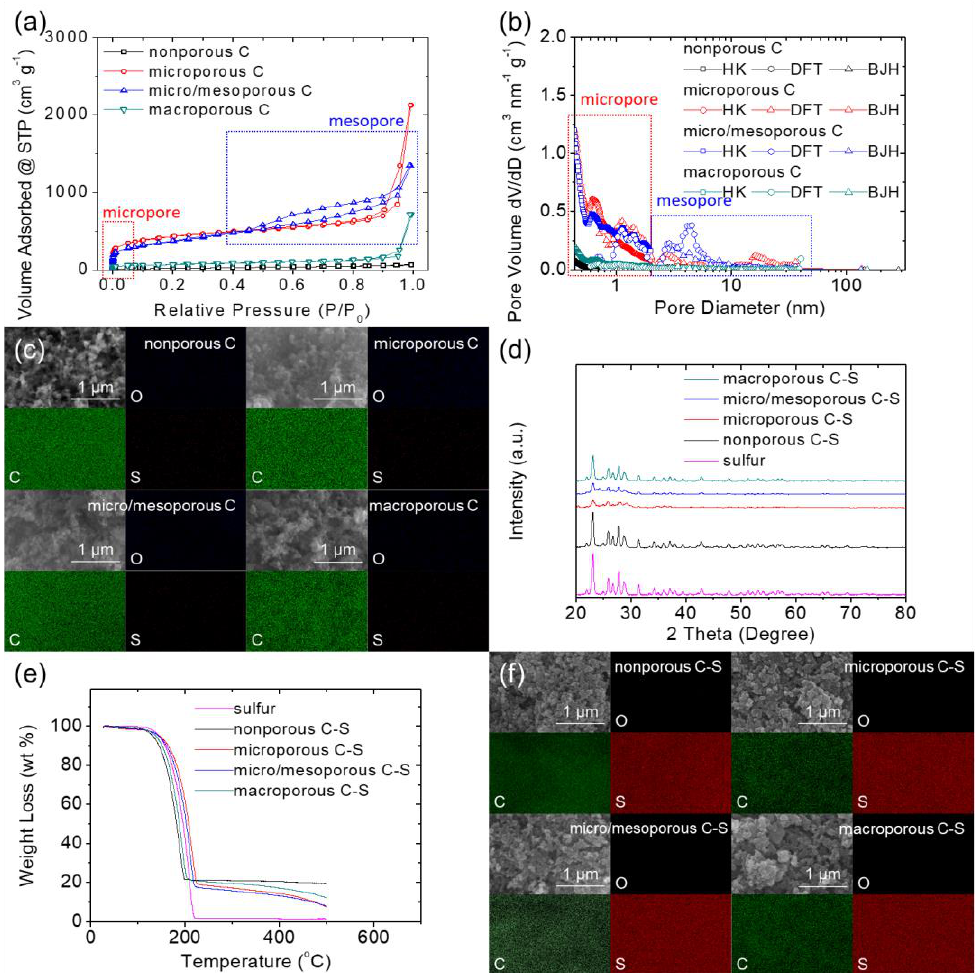
Figure 1. Material characteristics: ( a ) nitrogen adsorption–desorption isotherms (ISOs), ( b ) pore size distributions (PSDs), and ( c ) scanning electron microscopy and energy dispersive X-ray spectrometry (SEM/EDS) of various carbons. ( d ) X-ray diffraction (XRD), ( e ) thermogravimetric analysis (TGA), and ( f ) SEM/EDS of various carbon–sulfur (C–S) nanocomposites.